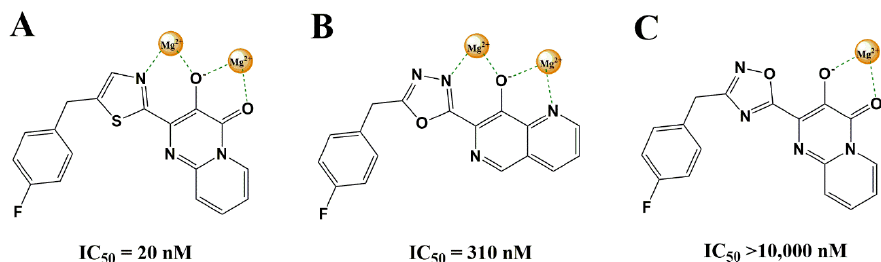
Figure 6. Coordination of Mg 2 + ions by azole-substituted pyrido[1,2-a]pyrimidines ( A ) and 1,6-naphthyridines ( B ) of HIV-1 integrase. In the 1,2,4-oxadiazole ( C ) the nitrogens lone